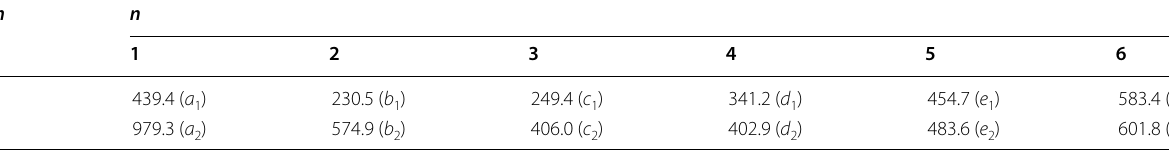
Table 2 Natural frequencies for i = 2 and j = 6